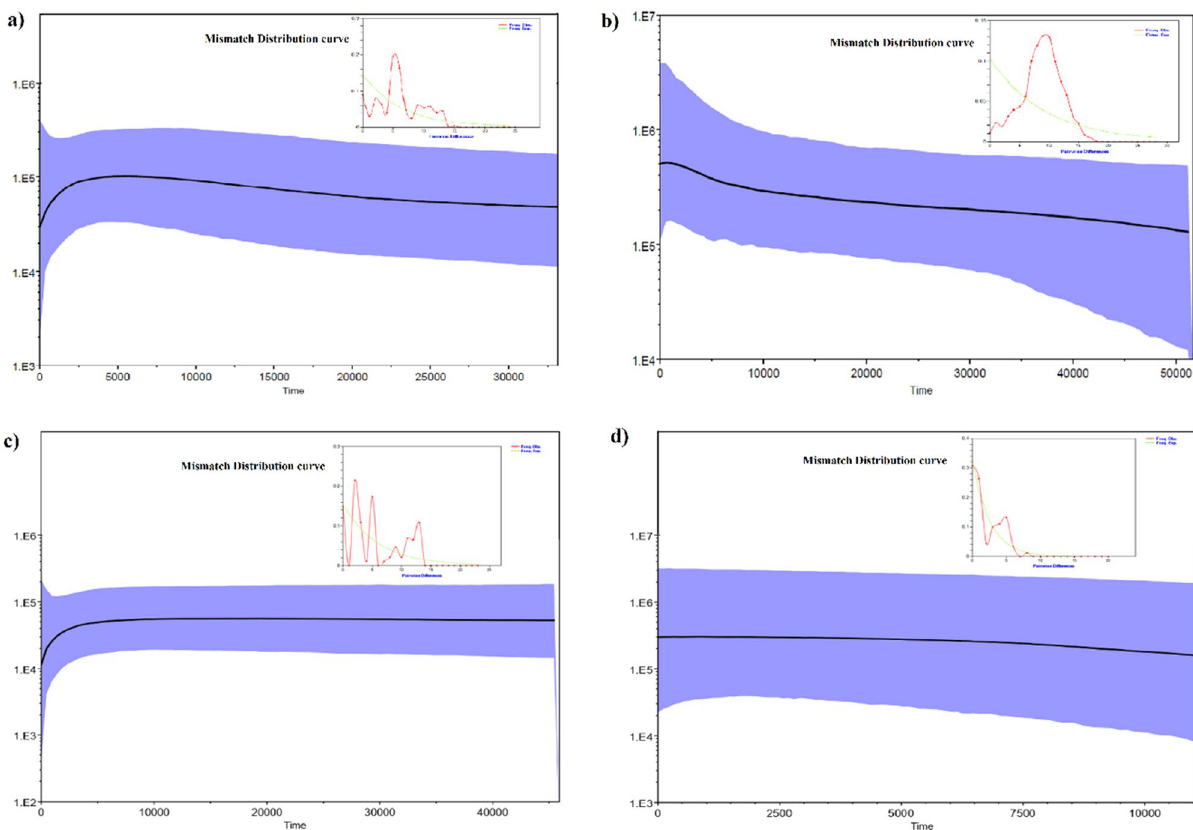
Figure 5. Demographic history of red panda populations estimated using Bayesian skyline plot (BSP). ( a ) Himalayan red panda, (b) Chinese red panda, (c) Himalayan red panda- KL India population and ( d ) Himalayan red panda- Arunachal Pradesh population. The solid line shows the median estimates of Ne τ (Ne = effective population size; τ = generation time), and the blue area around median estimates show the 95% highest posterior density (HPD) estimate of the historic effective population size. The timing of events was estimated assuming a substitution rate of 1.2 × 10 –7 calculated for red panda. Mismatch distributions curves of pairwise differences of each red panda populations are shown within the corresponding BSP